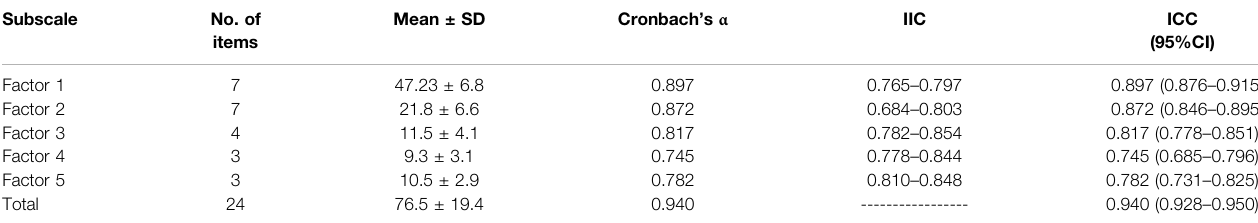
TABLE 3 | Reliability assessment criteria of the study scale ( n = 500). Subscale